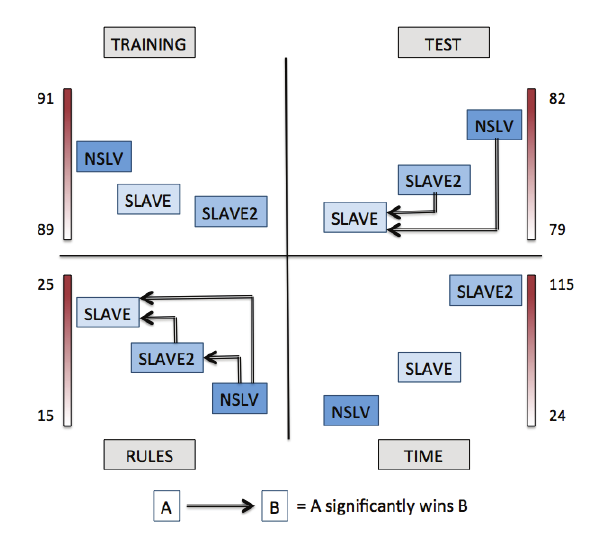
Fig. 9. Representation of the significant differences be- tween the